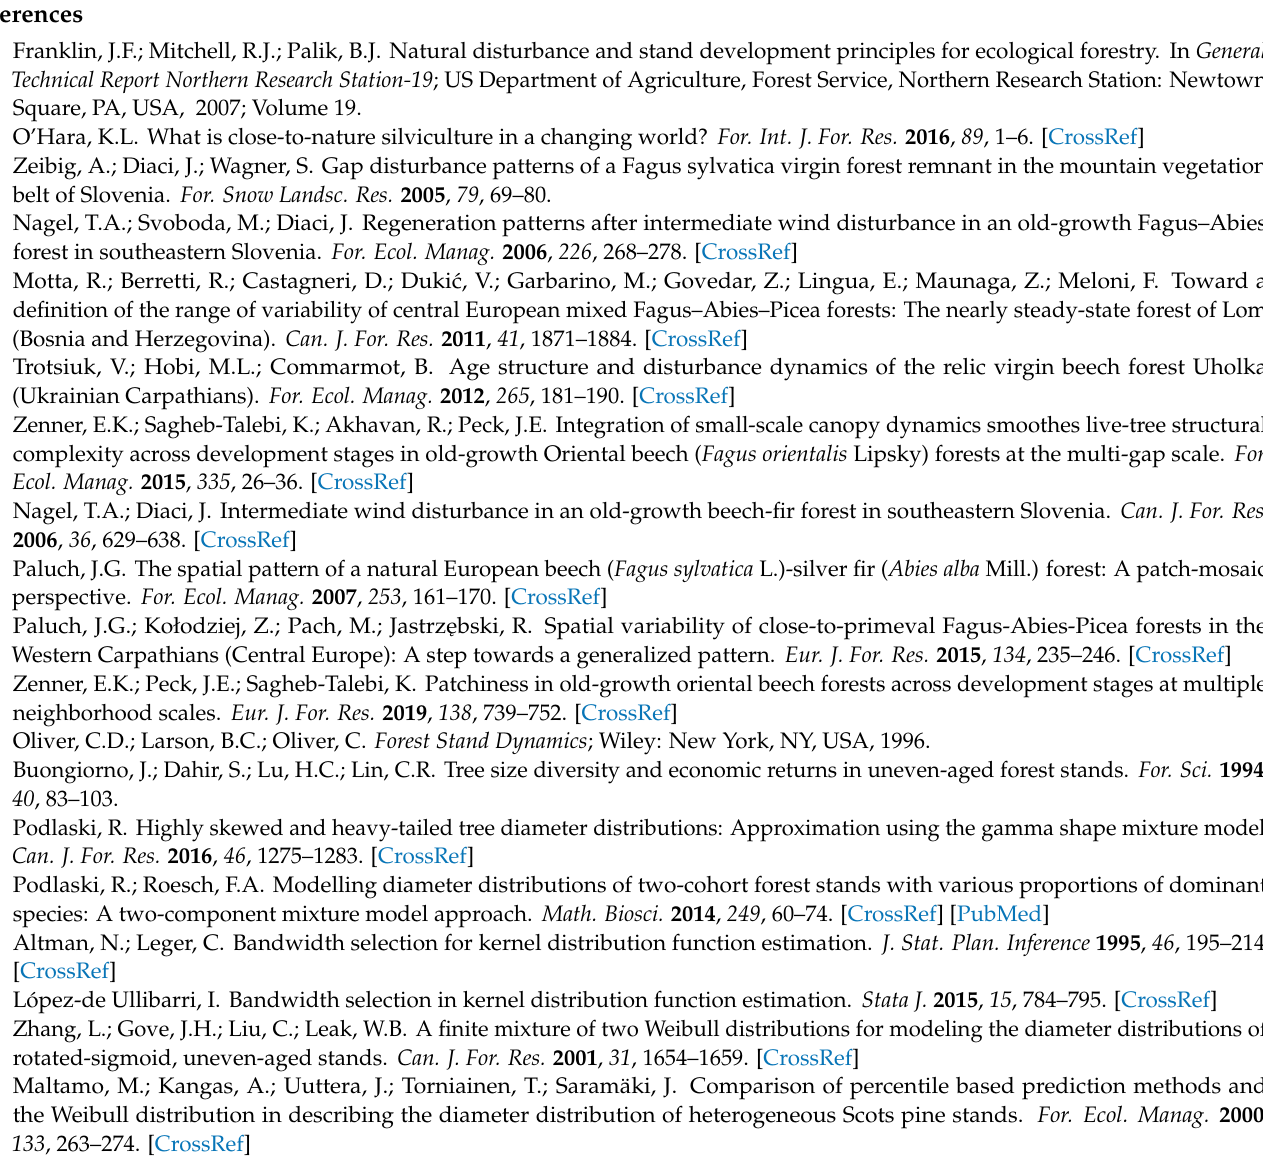
Figure A5. Histogram of DBH observations for sample 1 ( a ), sample 2 ( b ), and sample 3 ( c ). Superimposed are pdfs of NK, GSM, and mixture of log-normal models. The pdf of the gamma mixture model has been not shown for the ease of